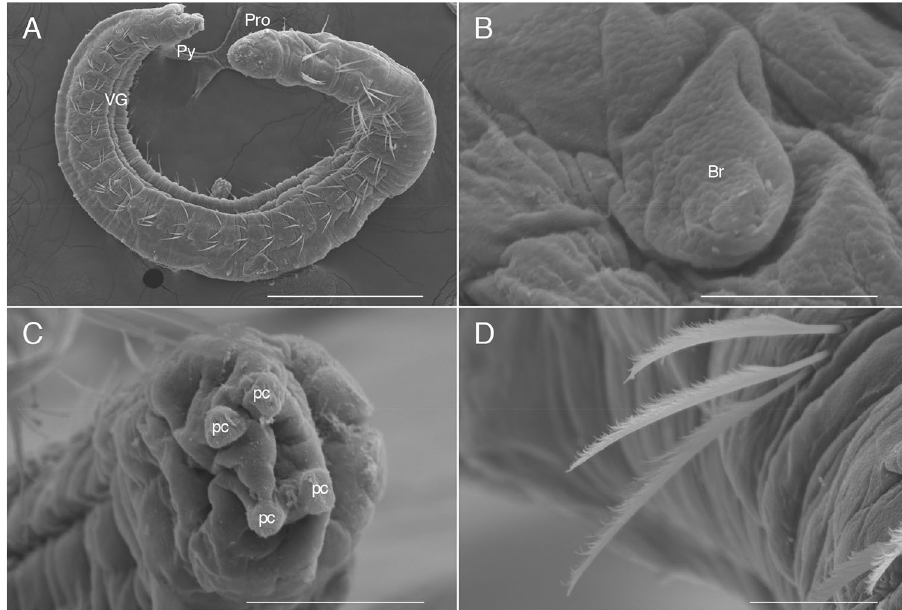
Figure 4. SEM photographs of Thoracophelia minuta sp. nov., paratype. A, whole body. B, branchia. C, pygidium. D, chaetae. Scale bars: A, 300 μm; B, 10 μm; C, 50 μm; D, 20 μm. Abbreviations: Br, branchia; pc, pygidial cirri; Pro, prostomium; Py, pygidium; VG, ventral groove. The figure was created with Adobe Illustrator v CS6 and Photoshop v